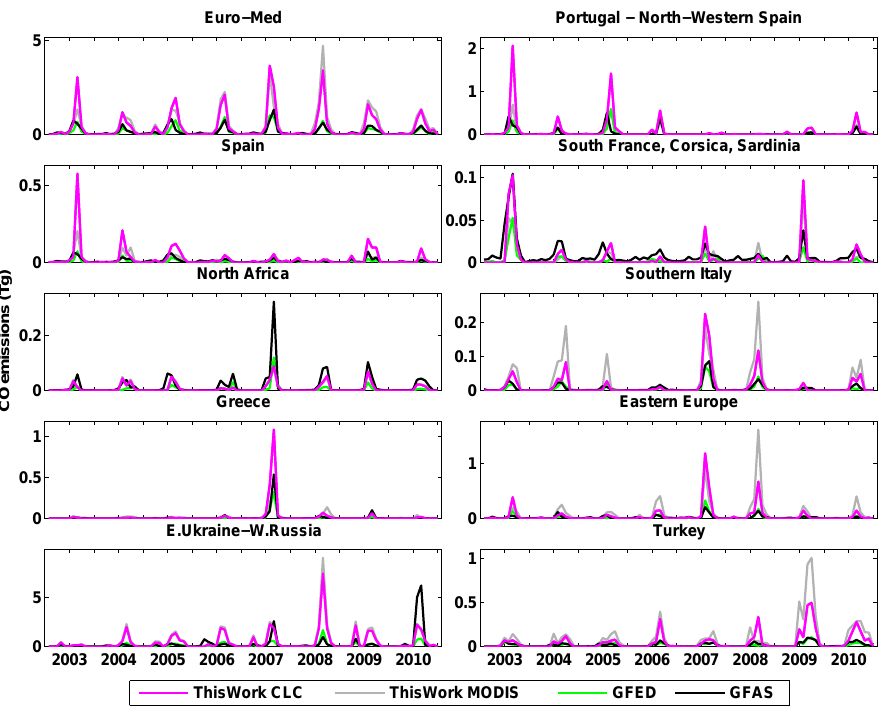
Fig. 8. Monthly emissions of CO in several subregions of Europe and the Mediterranean area according to this work, using CLC or MODIS MCD12 vegetation databases, and according to the GFEDv3 and the GFASv1 inventories. Detail on each inventory’s specifications is pro- vided in Table 6.